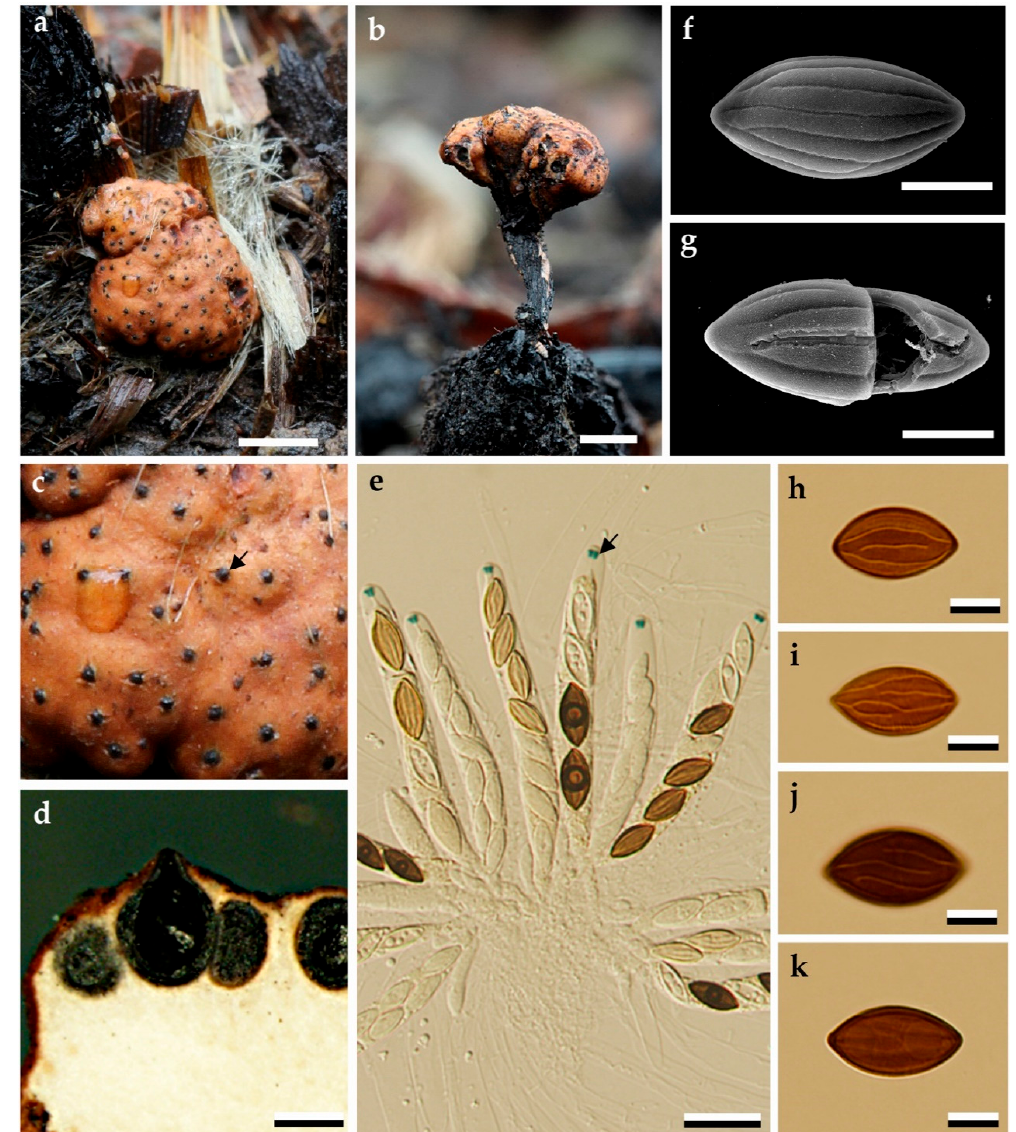
Figure 1. Morphological characteristics of Stromatoneurospora phoenix (specimen BBH 42282). ( a , b ): stromata in the natural habitat; ( c ): stromatal surface and ostioles; ( d ): longitudinal section of stroma showing perithecia and the tissue below the perithecial layer; ( e ): asci with apical apparatus bluing in Melzer’s reagent (black arrow); ( f , g ): ascospores by scanning electron microscopy (SEM); ( h – k ): ascospores by light microscopy. Scale is indicated by bars (( a ): 2 mm. ( b ): 1 mm. ( d ): 500 µm; ( e ): 20 µm, ( f – k ): 5 µm).